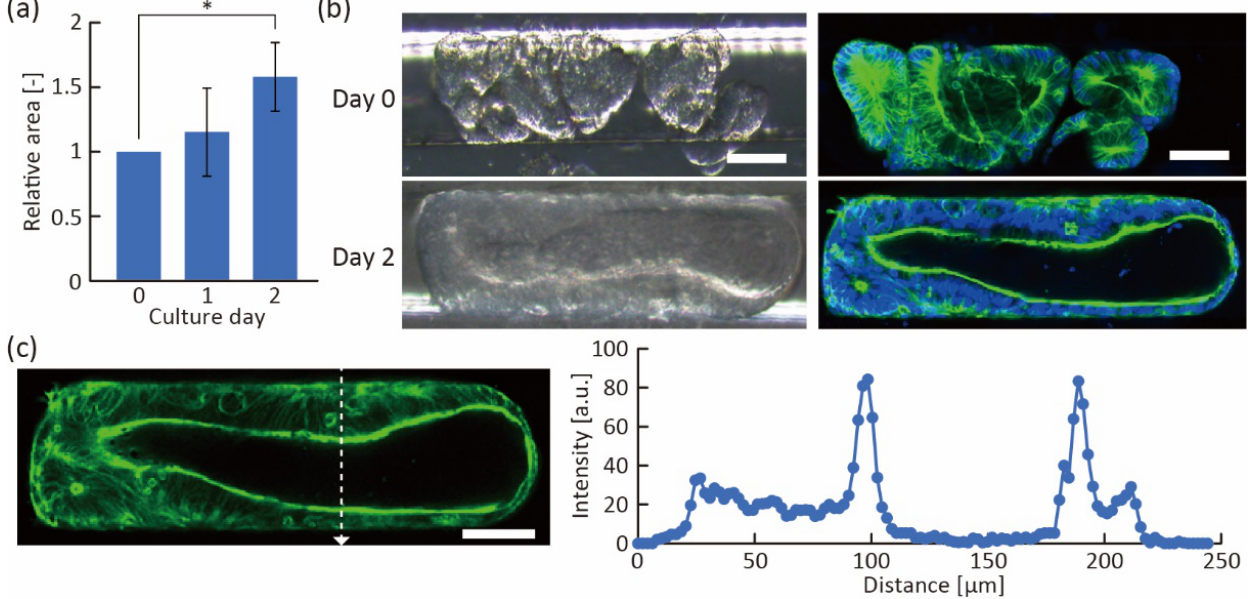
Figure 6. Fusion of trapped organoids. ( a ) The relative area of the trapped organoids calculated from microscope images ( n = 4, mean ± s.d., * p < 0.05, Tukey–Kramer test). ( b ) Bright-field (left) and fluorescent (right) images of trapped organoids at 0 and 2 days of culture. Green shows actin and blue shows cell nuclei. ( c ) Profile of fluorescent intensity in the white dotted line of the fluorescent image (shown in Figure 6b), indicating actin. Scale bars are 100 µm.